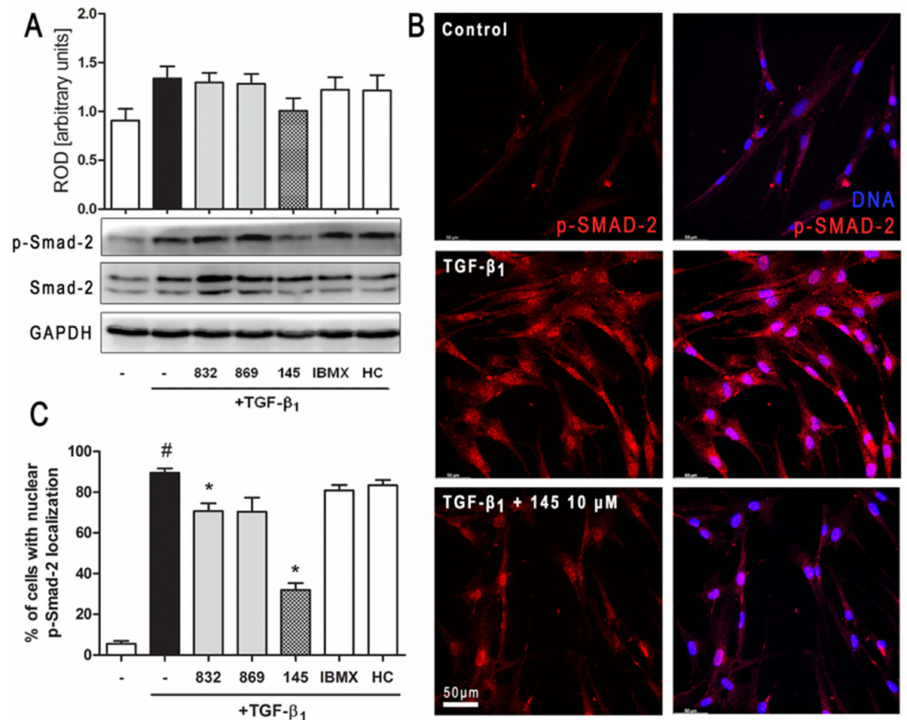
Figure 6. Compound 145 limits TGF- β 1 -induced Smad-2 phosphorylation and nuclear translocation in MRC-5 cells. Lung fibroblasts were pre-incubated with the studied compounds (10 µ M) for 1 h, and then TGF- β 1 (5 ng / mL) was added for 1 h. ( A ) Representative immunoblot and densitometry